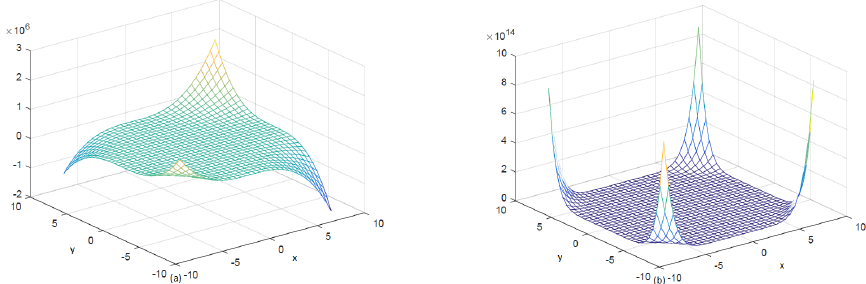
Figure 16: Plotting of (a) M-polynomial and (b) NM-polynomial of